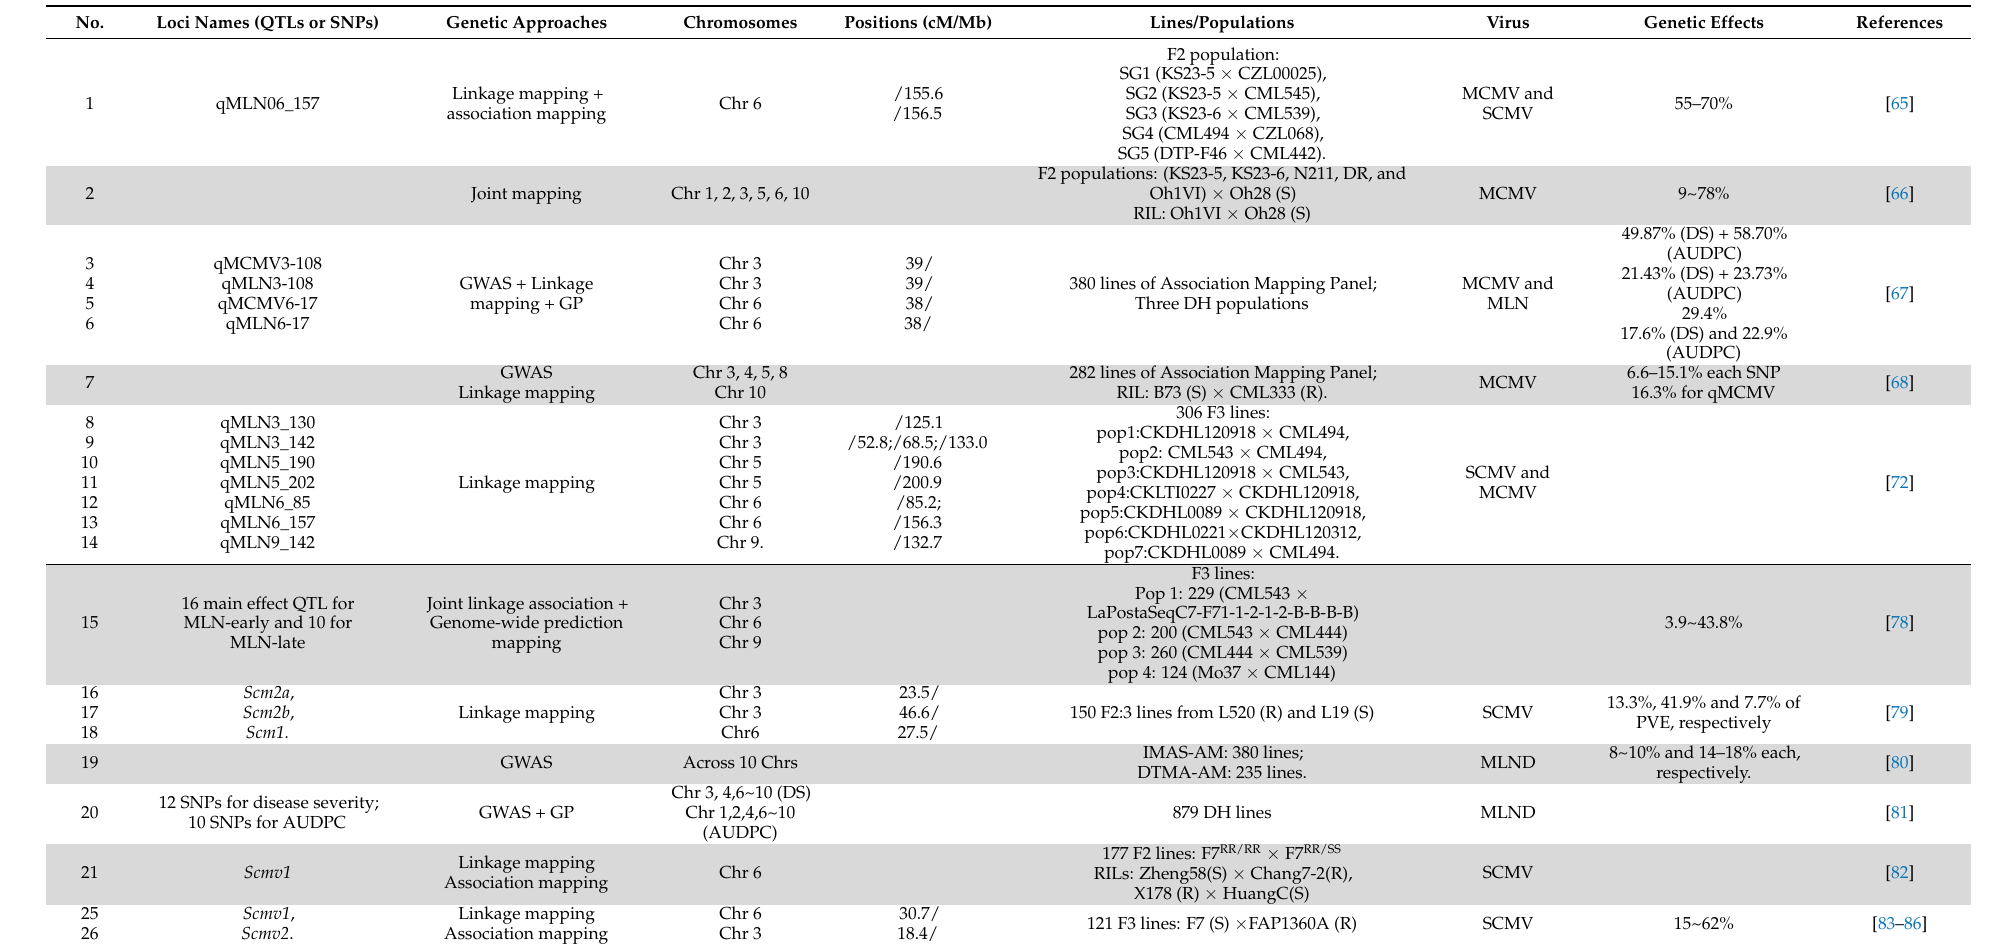
Table 1. Summary of genetic loci identified for MLN disease